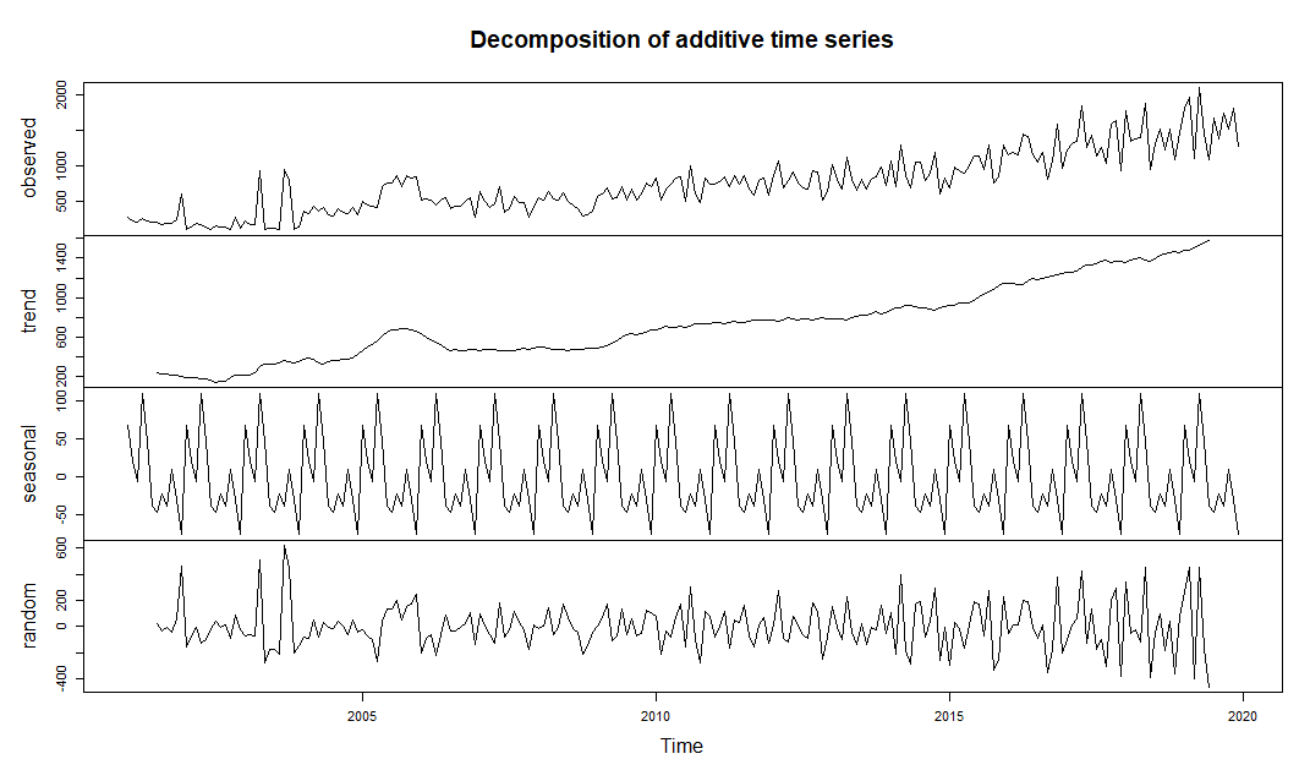
Figure 9. Decomposition of the “Palmet” time series. Note: The numbers on the y-axis represent the absolute number multiplied by 1000.